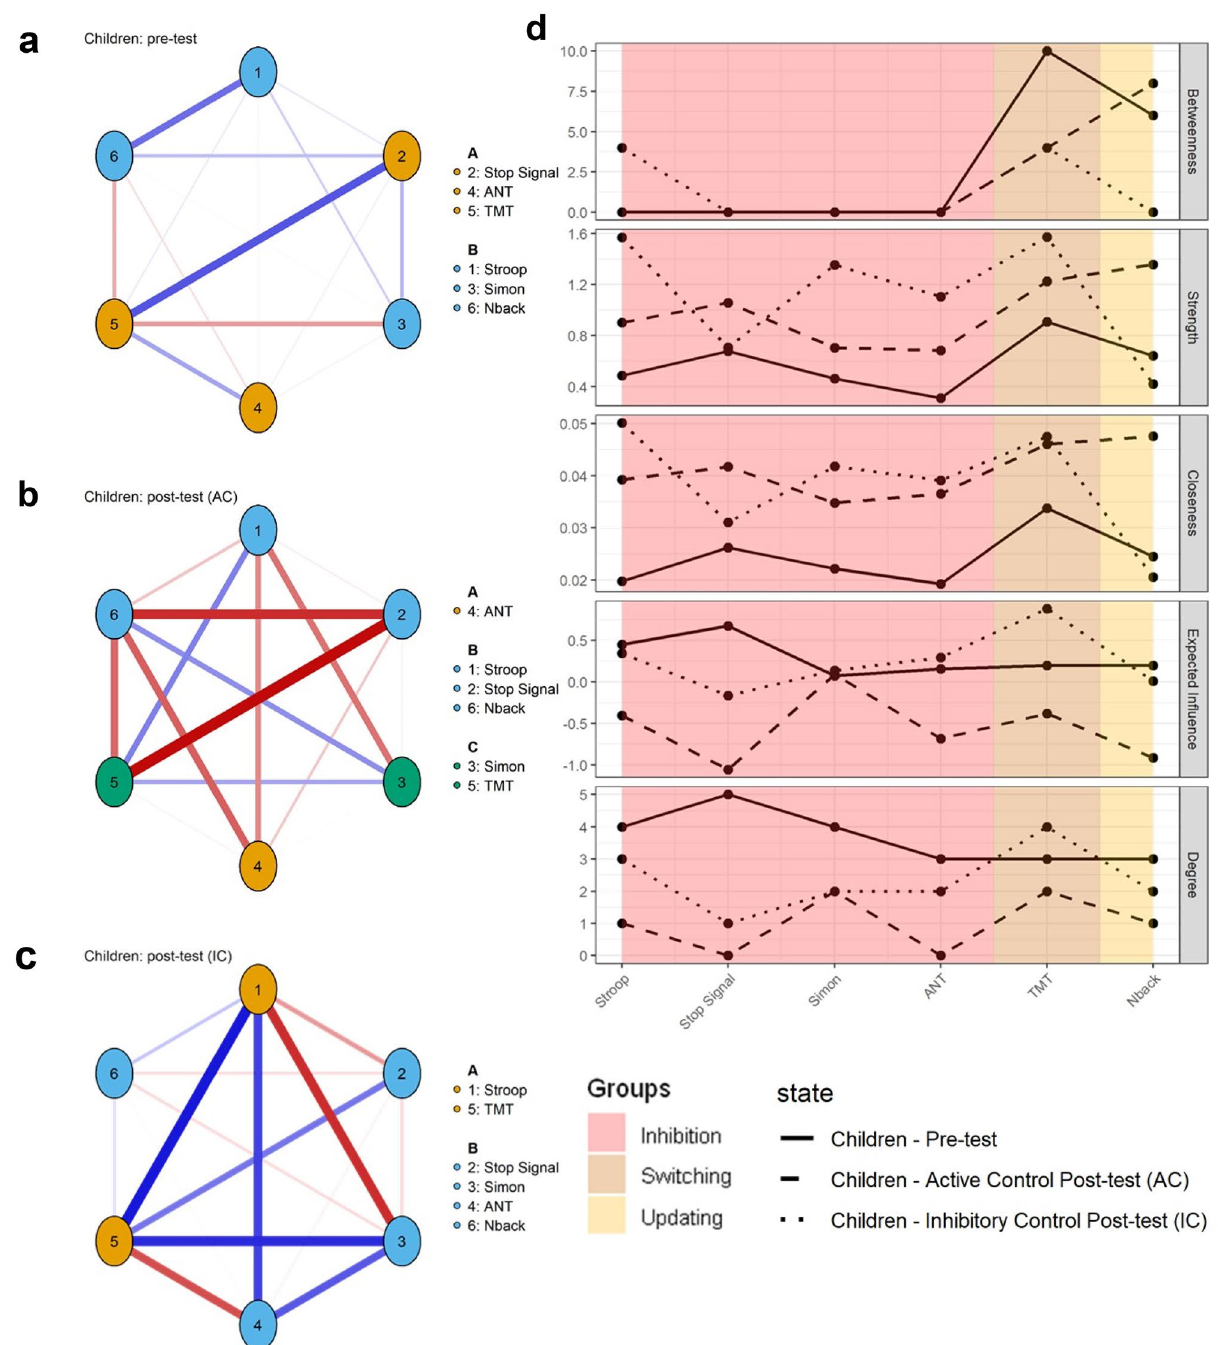
Figure 2. Six-nodes networks for children, before ( a ), after active control training (AC group; b ) and after inhibitory control (IC group; c ) training with the corresponding centrality indices ( d ). Color of nodes correspond to the communities. Each number in the networks corresponds to an EF task (see details in the